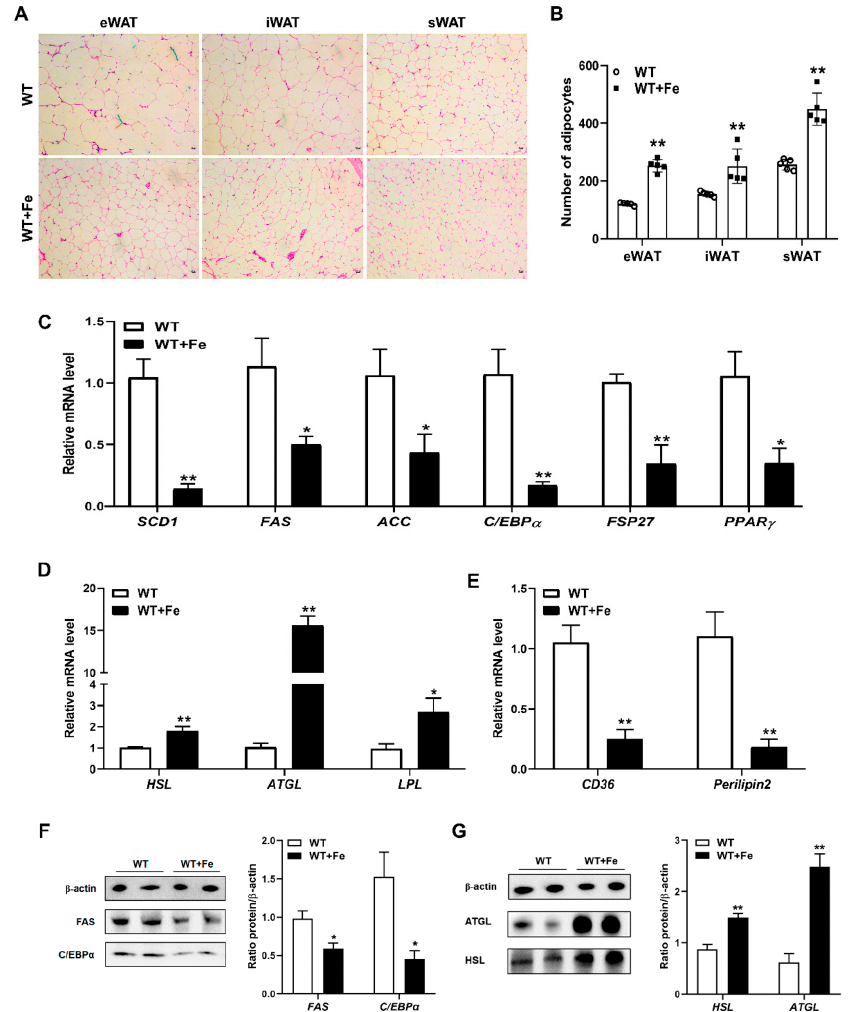
Figure 3. A high-iron diet inhibited adipogenesis and promoted lipolysis in adipose tissues. ( A ) H&E staining of eWAT, iWAT, and sWAT. ( B ) Statistical number of adipocytes ( n = 5). ( C ) SCD1 , FAS , ACC , C/EBP α , FSP27 and PPAR γ mRNA levels in adipose tissue. ( D ) HSL , ATGL and LPL mRNA levels in adipose tissue. ( E ) CD36 and Perilipin2 mRNA levels in adipose tissue. ( F ) FAS and C/EBP α protein levels in adipose tissue. ( G ) HSL and ATGL protein levels in adipose tissue. Data are presented as the mean ± SEM. * p < 0.05, ** p < 0.01. Original western blot figures in Figure